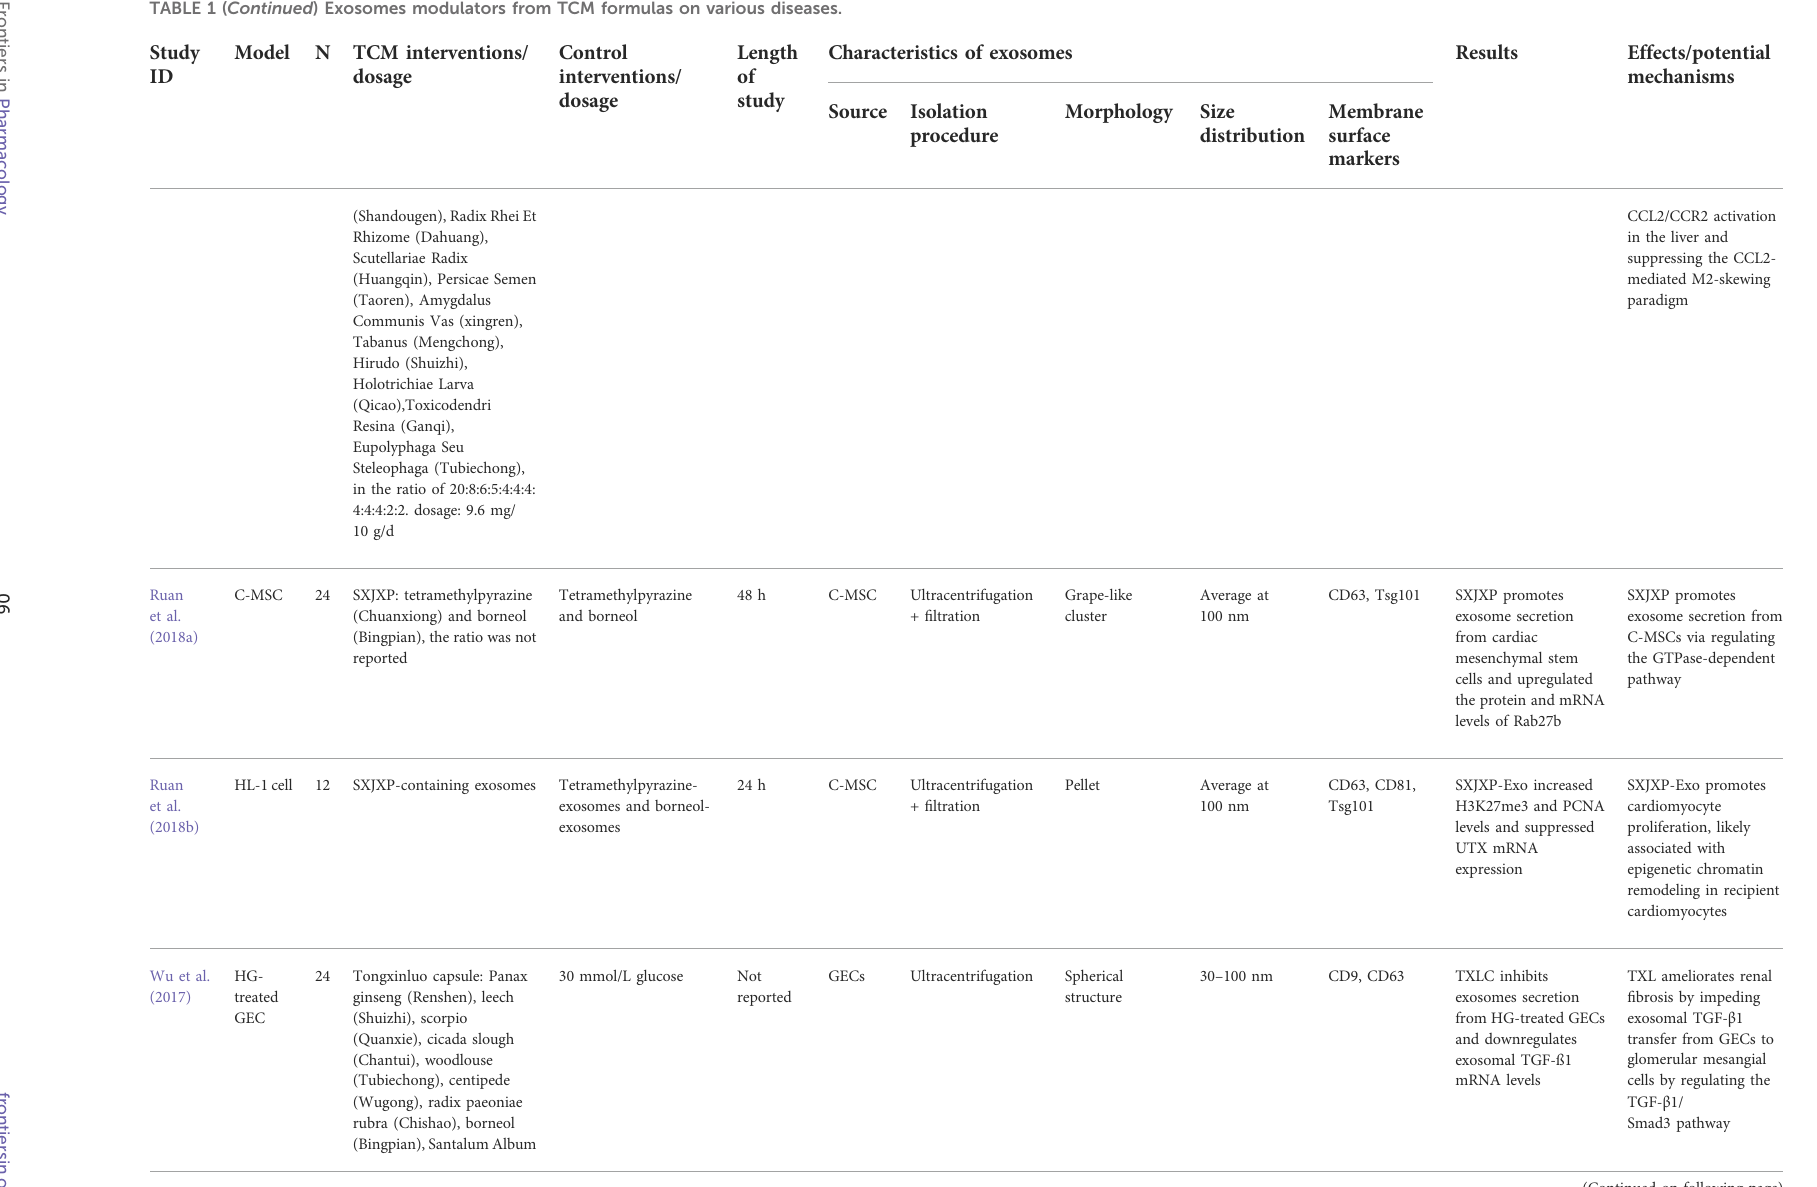
TABLE 1 ( Continued ) Exosomes modulators from TCM formulas on various